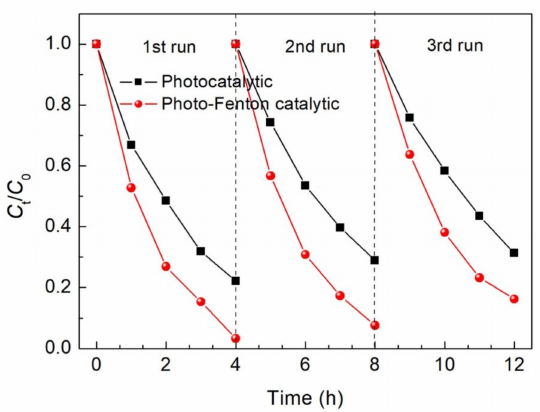
Figure 7. Photocatalytic and photo-Fenton catalytic recyclabilities of the 15% Ag 2 S/BiFeO 3 composite for the degradation of MO under visible-light